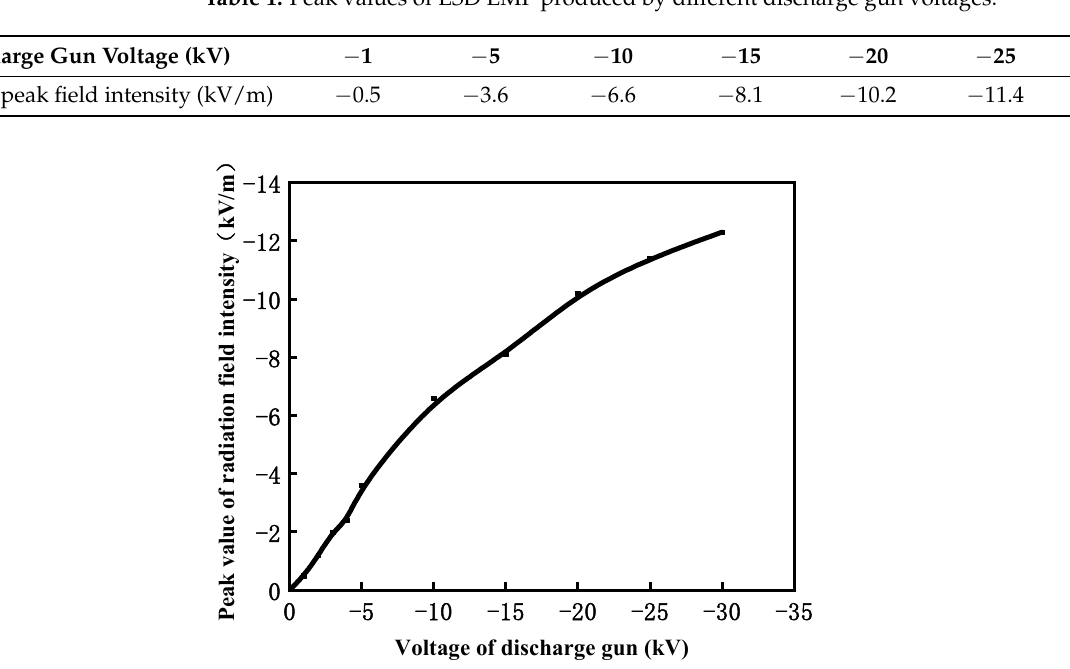
Table 1. Peak values of ESD EMP produced by different discharge gun voltages.